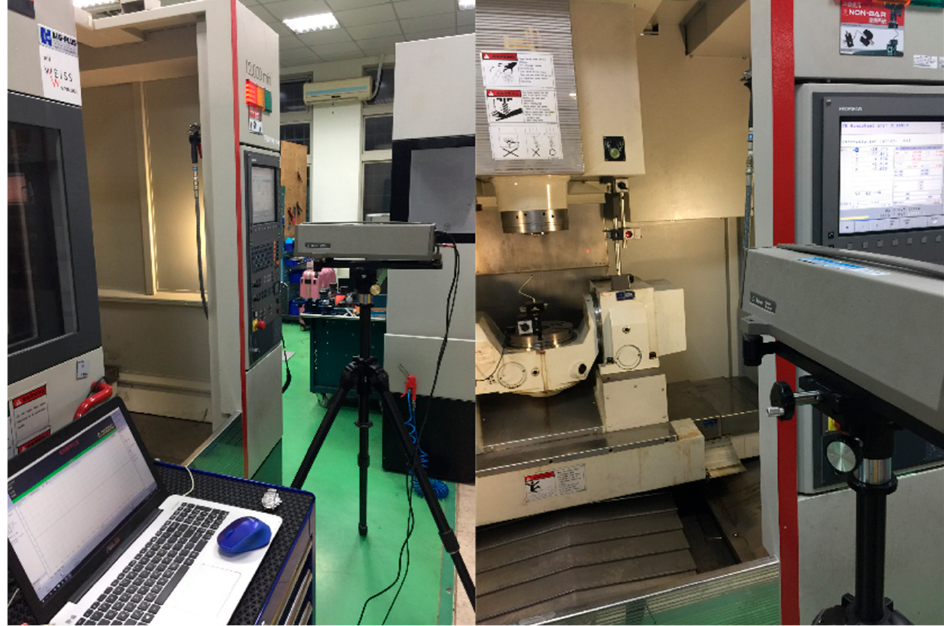
Figure 4. Implementing the 5530 Laser Calibration System on the CNC machine.